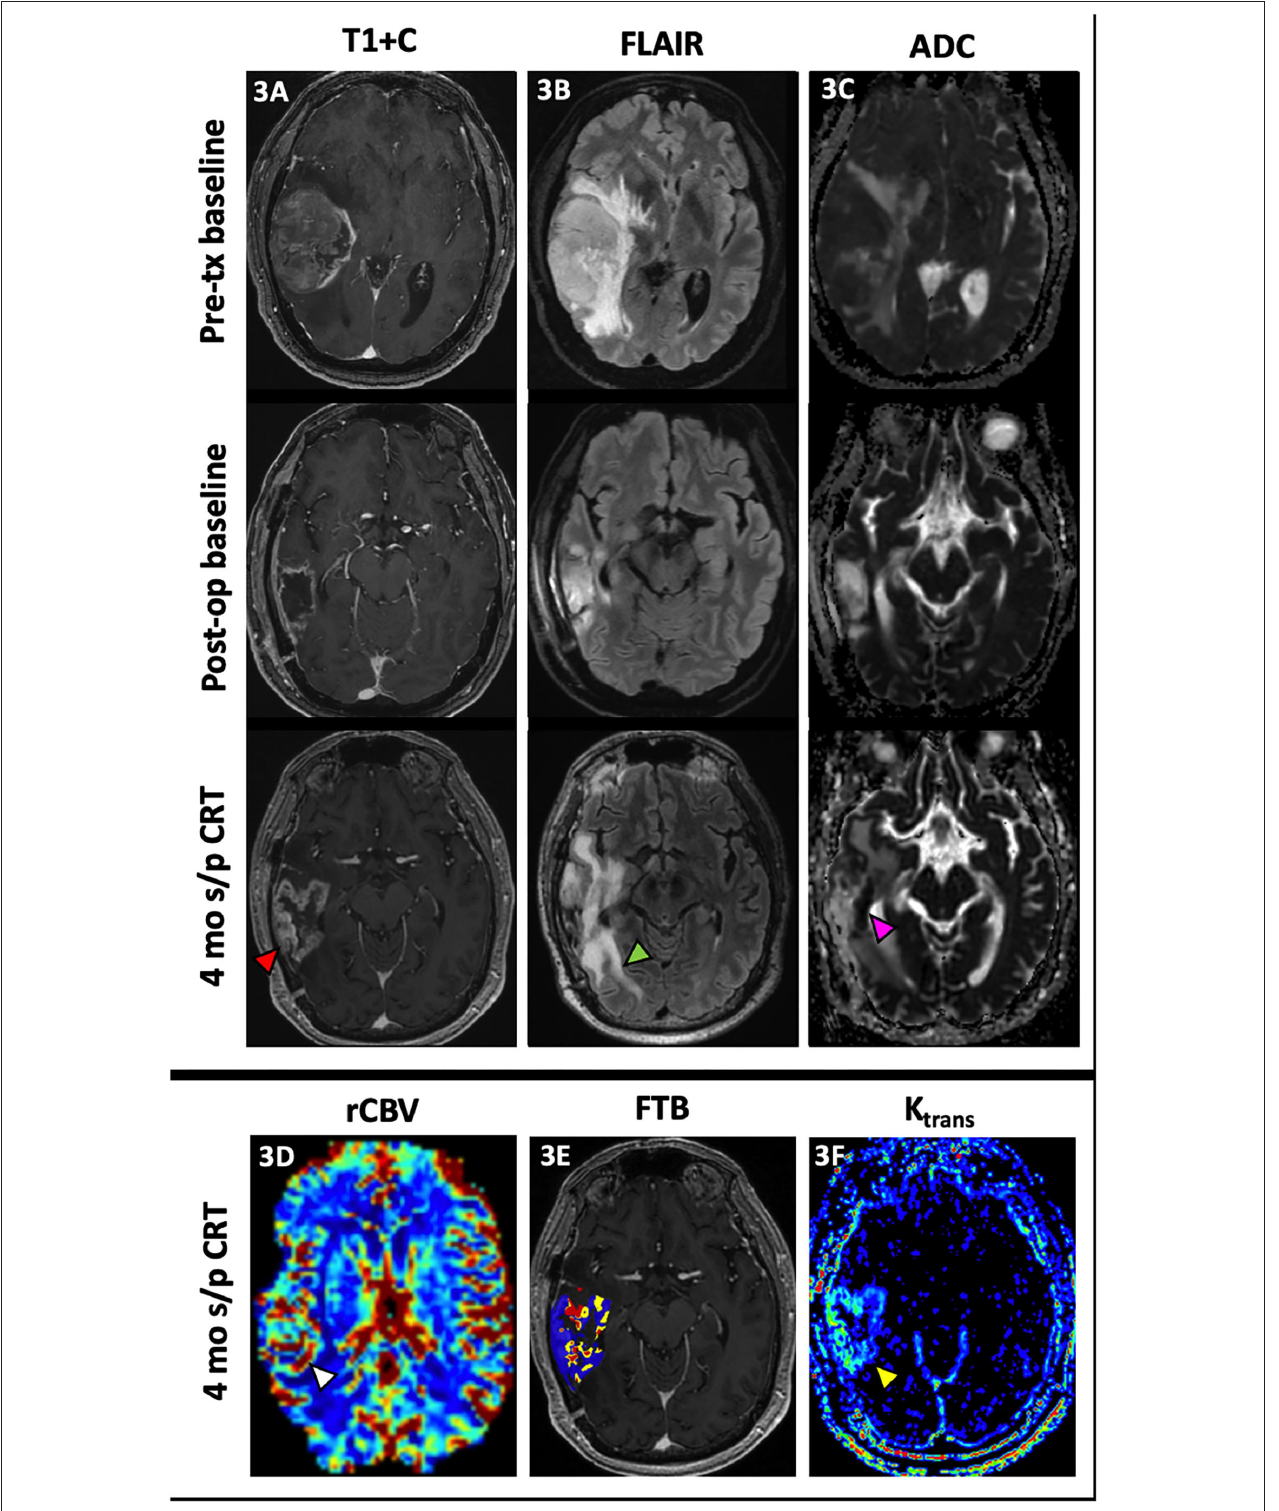
FIGURE 3 | Admixture of treatment effect and tumor. A 68 year-old male with GBM (IDH wt, MGMT + ) initially presented with a large enhancing right temporal lobe mass [ (A) , top row] with extensive perilesional FLAIR hyperintensity [ (B) , top row] and diffusion restriction [ (C) , top row]. After resection, there is mild